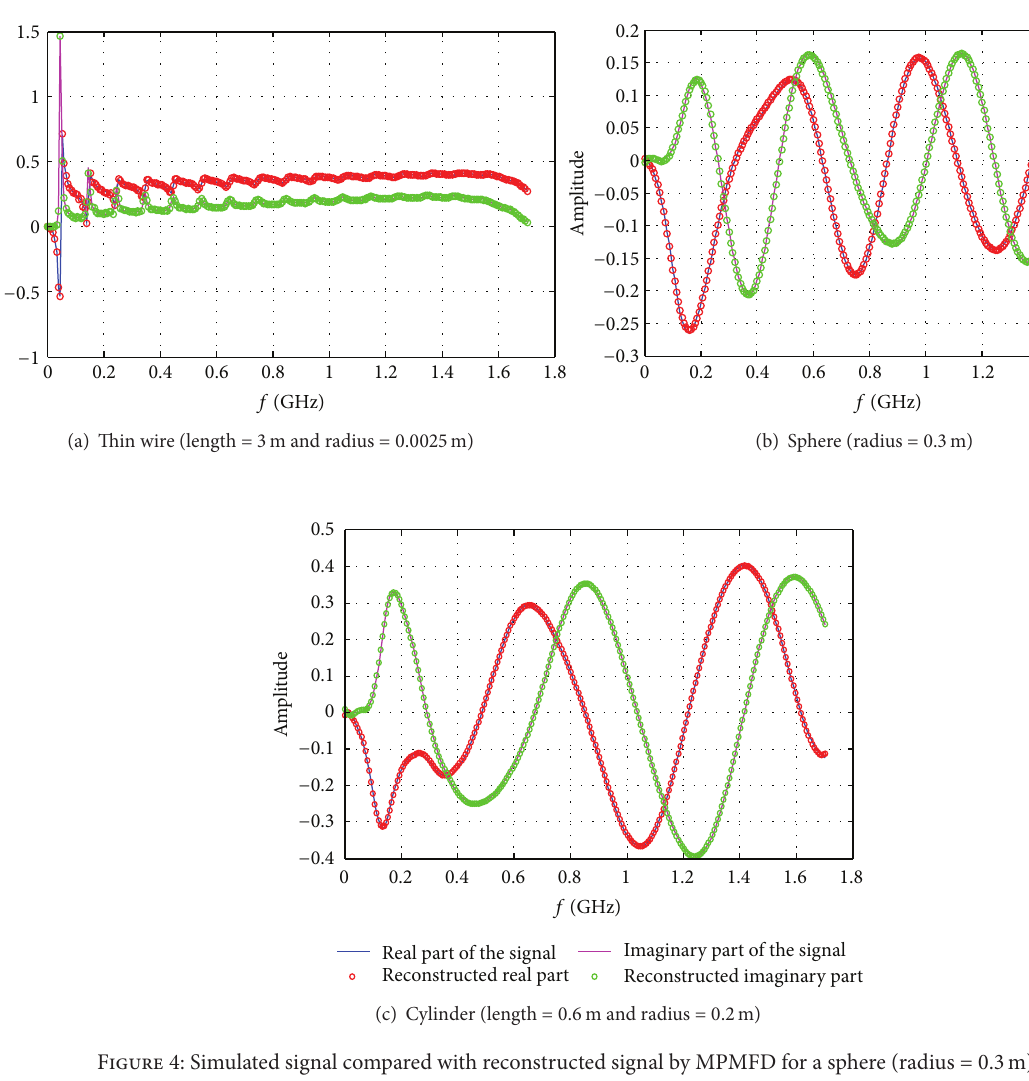
conducting target: thin wire (length: 𝑙 = 1, 1.3, 1.5, 1.7, 2, 2.4, 2.5, 3 m, and radius: 𝑟 = 0.0025 m for all the wires), sphere (radius: 𝑟 = 0.15 , 0.2, 0.28, 0.3, 0.35, 0.4, 0.45, and 0.5 m), and cylinder ( 𝑙 = 0.4 and 𝑟 = 0.17 m, 𝑙 = 0.4 and 𝑟 = 0.23 m, 𝑙 =